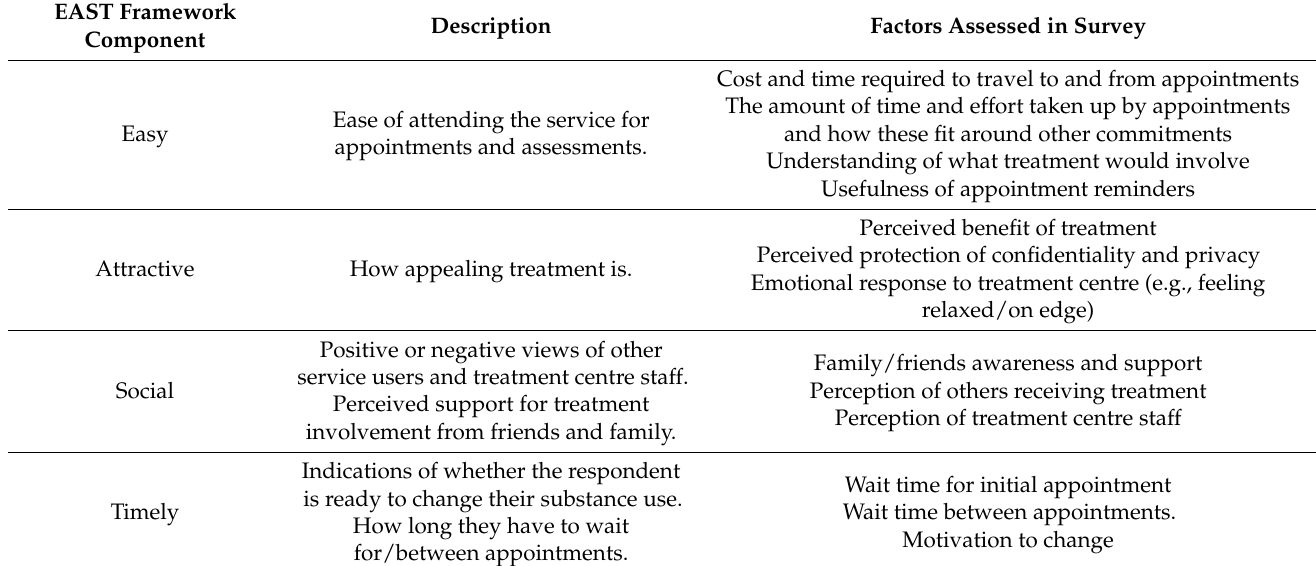
Table 1. EAST framework summary of factors